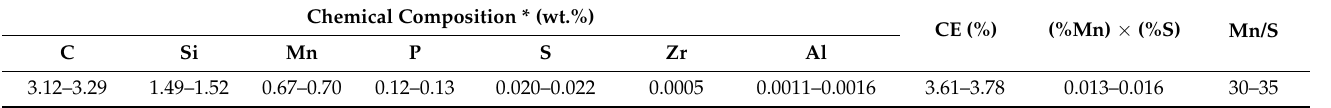
Table 1. Inoculated grey cast